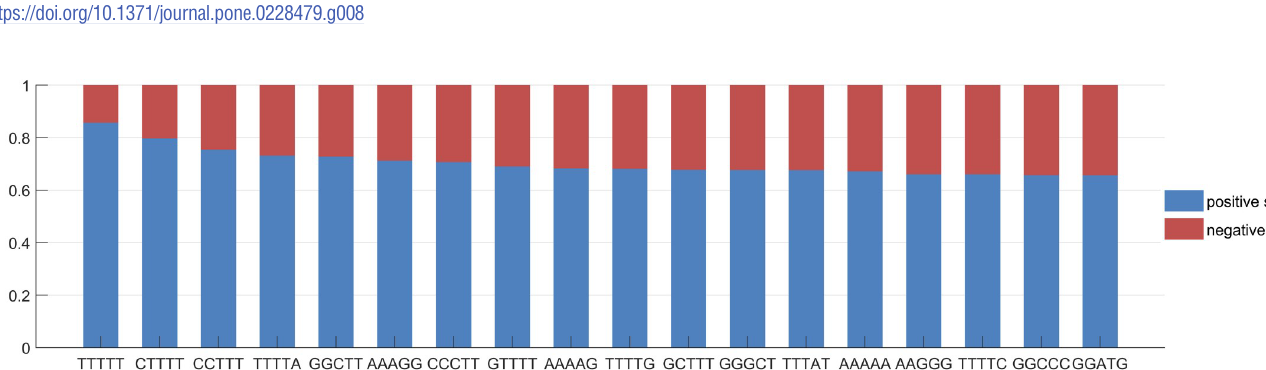
Fig 9. Pentamer nucleotide distribution. The figure shows the distribution ratio of each pentamer nucleotide in terminator sequences and non-terminator sequences.